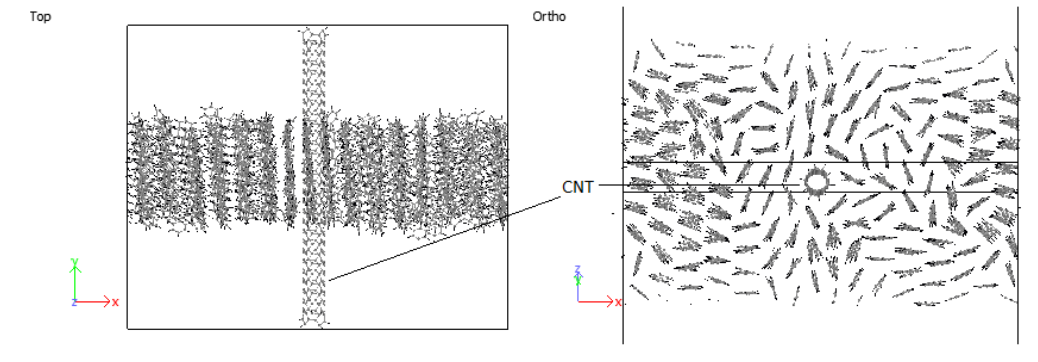
Molecules 2020 , 25 , x FOR PEER REVIEW Figure 28. Interaction: 4PPV-SWCNT (final). Figure 28. Interaction: 4PPV-SWCNT (final). Figure 28. Interaction: 4PPV-SWCNT (final).